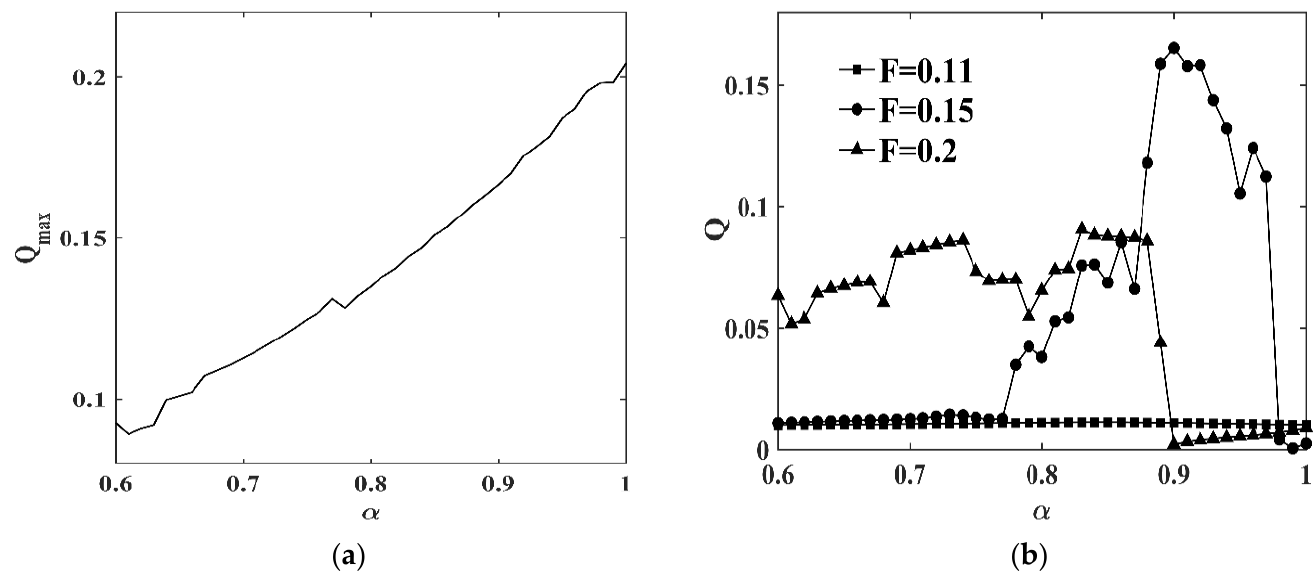
α . ( a ) Re- α for three different